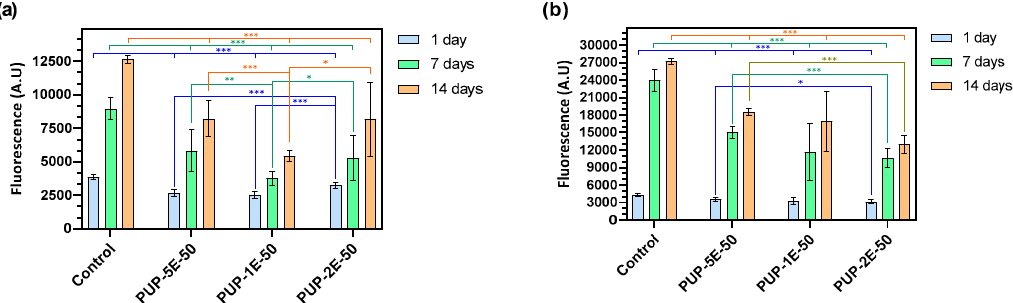
Figure 8. Adhesion and proliferation assay of ( a ) HOb cells ( b ) HC-a cells on the surface of PABA- based polyurethanes. Data show the mean value and standard deviation (n = 12). Statistical differ- ences were analyzed by analysis of variances (ANOVA) and Tukey’s Test, considering statistically significant difference when p ≤ 0.05 (*), p ≤ 0.01 (**) and p ≤ 0.001 (***).